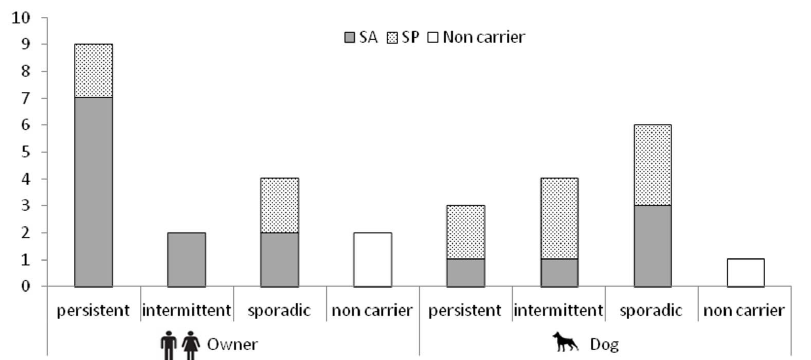
Figure 3. Number of investigated individuals (owners and dogs) with different S.aureus (SA) and S.pseudintermedius (SP) carriage status over the sample year (T0–T4). It should be noted that the sum is higher than the total number of isolates given that individuals could belong to 2 distinct carriage types depending on bacterial species.